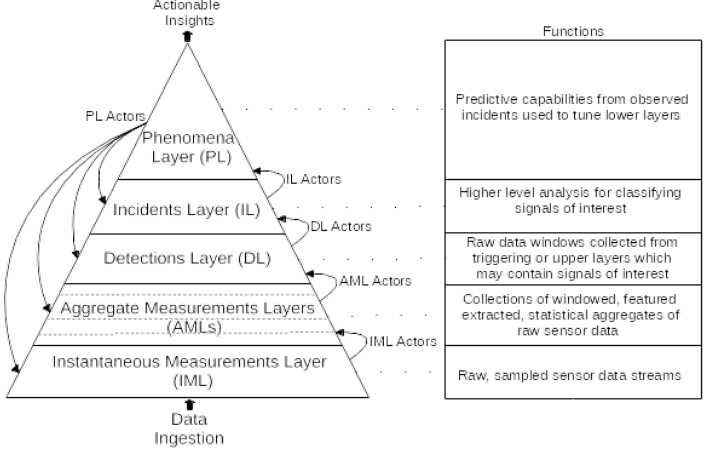
Figure 5. Mauka data model